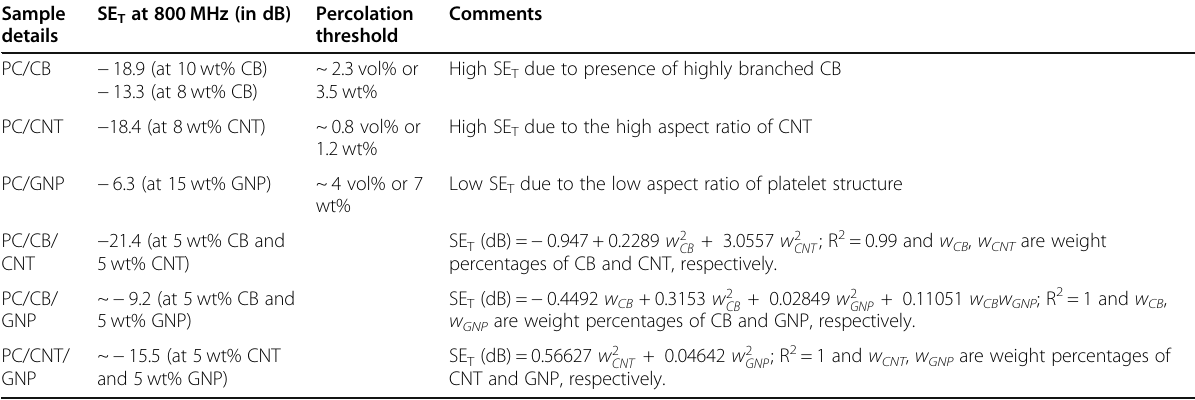
Table 2 Comparative study of shielding performance of single filler and a combination of fillers in the PC matrix Sample